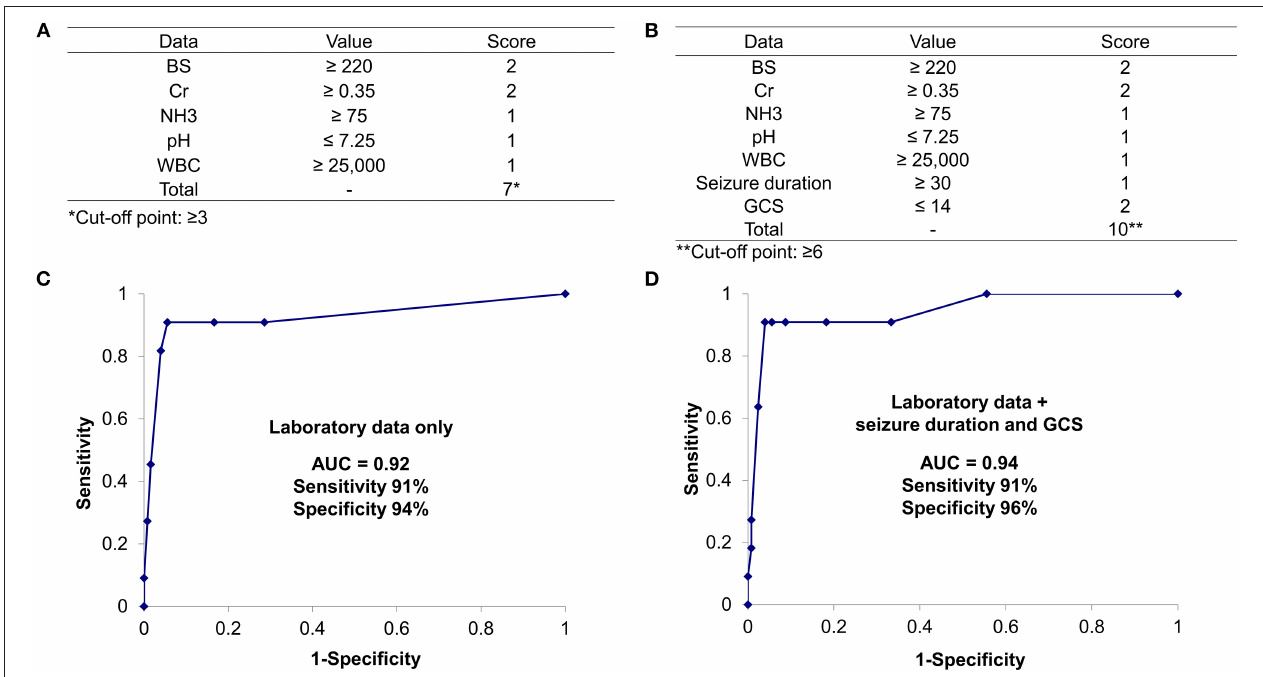
FIGURE 3 | The prediction scores for acute encephalopathy with biphasic seizures and late reduced diffusion (AESD) using only laboratory data, including blood sugar (BS) level ( ≥ 220 mg/dL, scored as 2 points), serum creatinine (Cr) level ( ≥ 0.35 mg/dL, 2 points), white blood count (WBC) ( ≥ 25,000/ µ L, 1 point), ammonia (NH3) level ( ≥ 75 µ g/dL, 1 point), and pH ( ≤ 7.25, 1 point) (A) . The prediction scores for AESD using laboratory data, seizure duration ( ≥ 30min, 1 point), and Glasgow coma scale (GCS) score ( ≤ 14, 2 points) (B) . Receiver–operator characteristic curve for the scoring model using only laboratory data (C) and laboratory data with seizure duration and GCS score (D) . Using the cutoff point at a total score ≥ 3, the sensitivity and the specificity are 91 and 94%, respectively, for the scoring model with only laboratory data (C) . In the scoring model using laboratory data with seizure duration and GCS score, using the cutoff point at a total score ≥ 6, the sensitivity and the specificity are 91 and 96%, respectively (D) . AUC, area under the